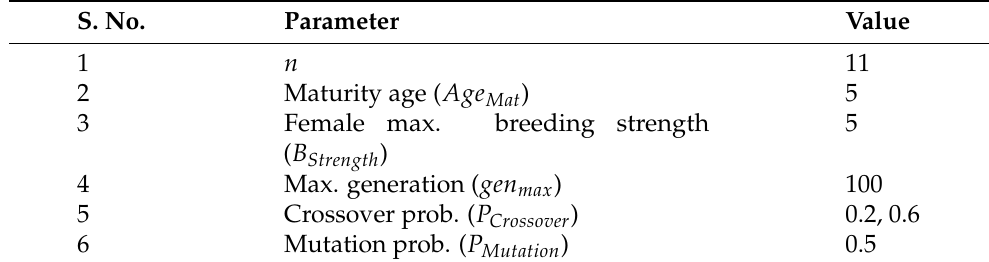
Table 3. Control parameters for Lion’s Algorithm.